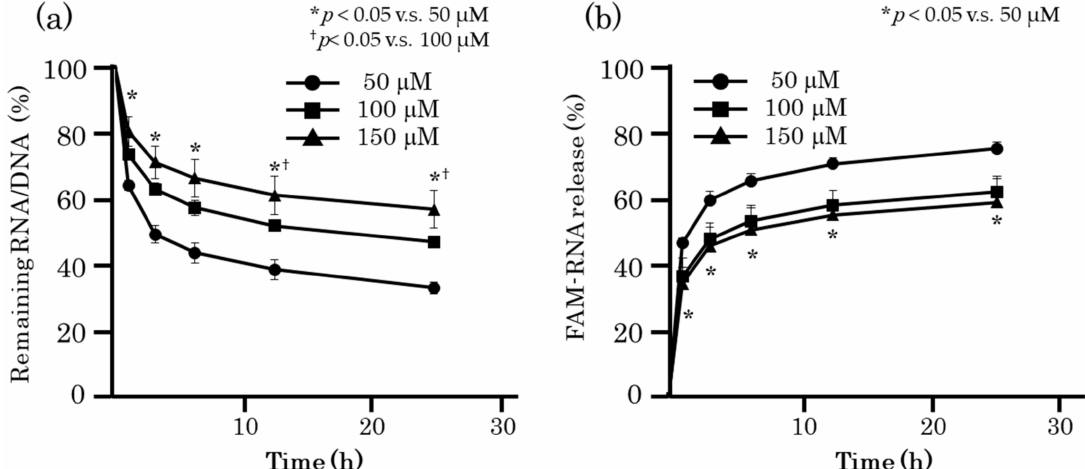
Figure 3. ORN-1 release from hexapodRD6 or RDgel prepared at di ff erent RNA / DNA concentrations. The same amount of 50, 100, or 150 µ M RNA / DNA was added on the Transwell chamber. ( a ) Time course of the amount of RNA / DNA remaining on the Transwell chamber. The amount of RNA / DNA at 1, 3, 6, 12, and 24 h after addition was calculated by subtracting the released amount from the total amount. ( b ) Time course of FAM-ORN-1 released from the RNA / DNA hydrogel. The fluorescence intensity of PBS in the lower chamber was measured at 1, 3, 6, 12, and 24 h after starting the experiment. The results are expressed as the mean ± SD of three independent experiments, * p < 0.05 compared with 50 µ M, † p < 0.05 compared with 100 µ